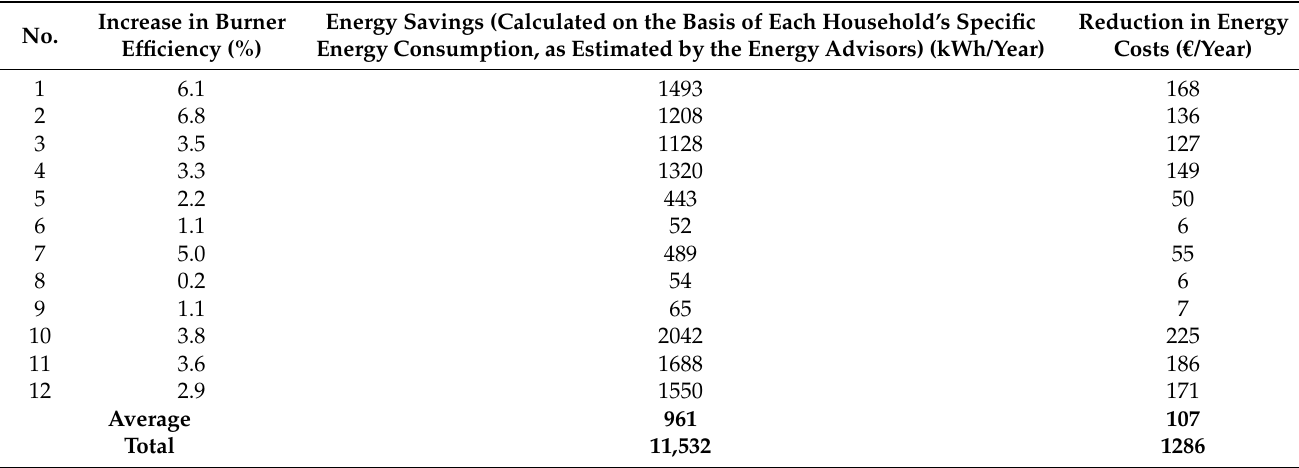
Figure 11. Impact of replacement of an old refrigerator on electricity consumption. Table 3. Energy savings and reduction in energy costs, due to maintenance of central heating systems in the Mountainous Living Lab.